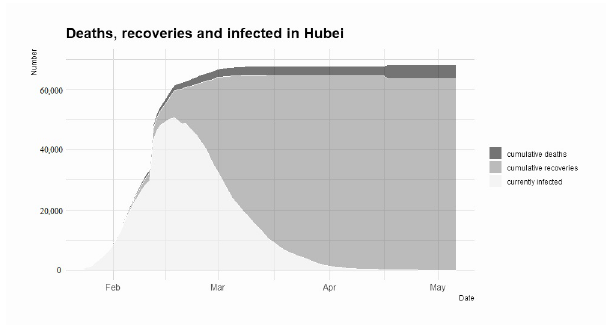
Figure 1. Cumulative number of infections, recoveries and deaths in